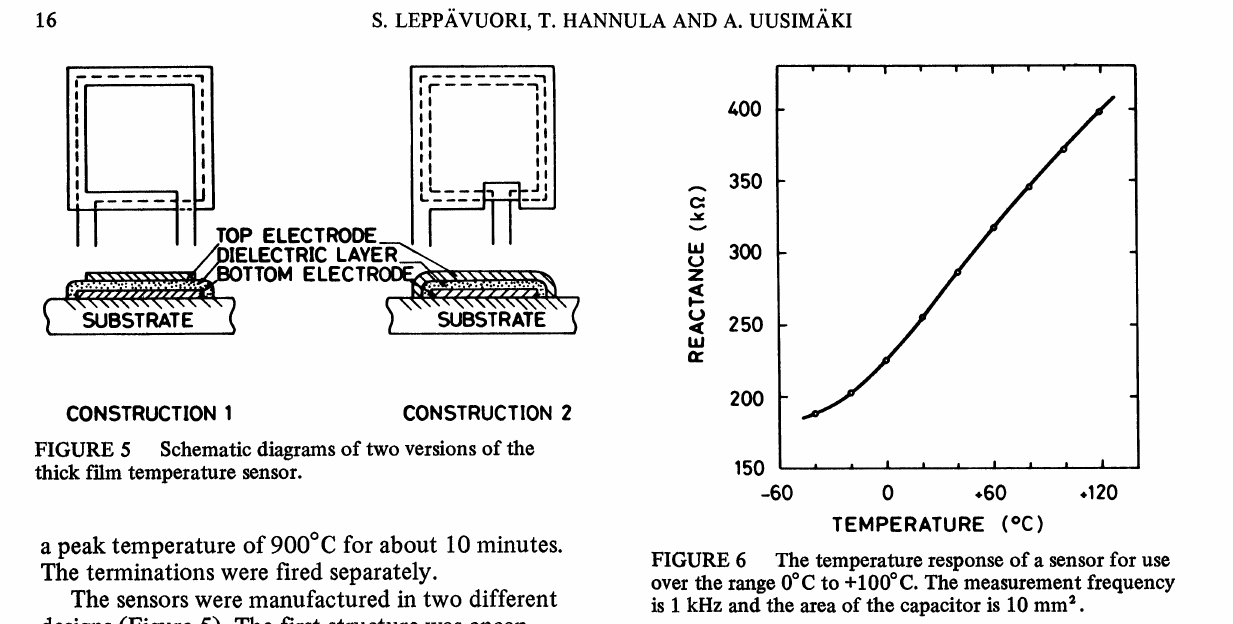
The temperature response of a sensor for use over the range 0C to +100 C. The measurement frequency is 1 kHz and the area of the capacitor is 10 mm2. was exponential and the results indicated 95% of the total change took place in less than minute.